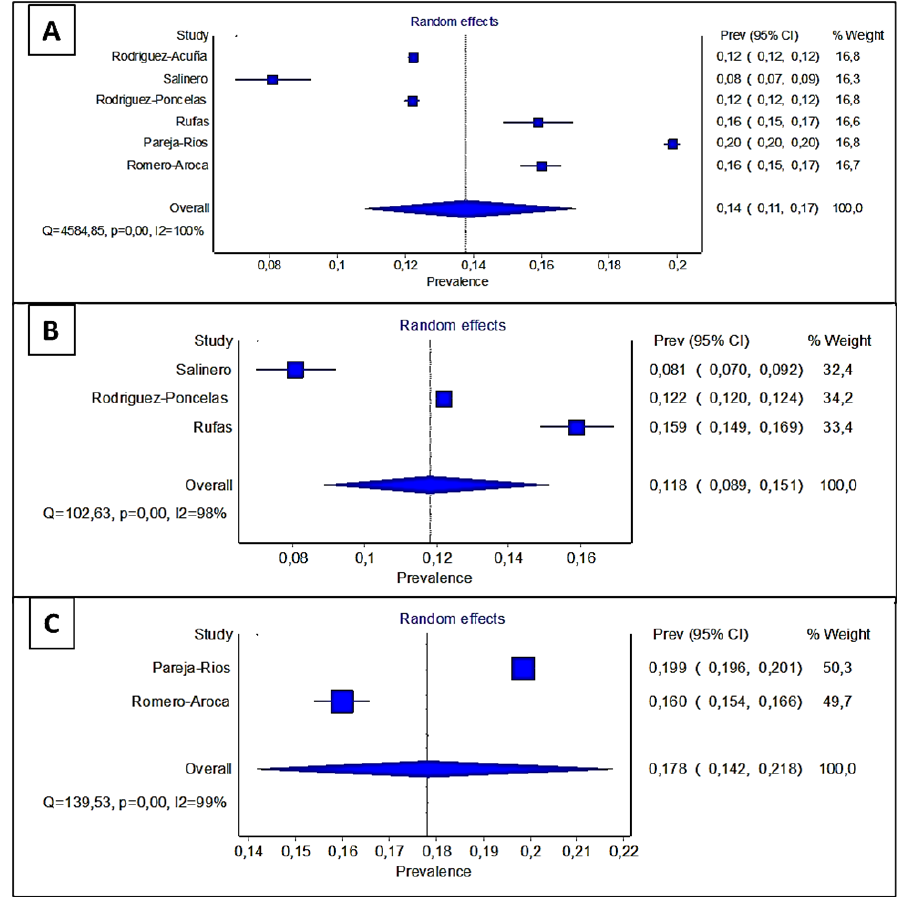
Figure 4. Forest plot of the reviewed publications on incidence. ( A ) Data of all studies, ( B ) data of studies with 5 years follow-up, ( C ) data of studies with 8 years